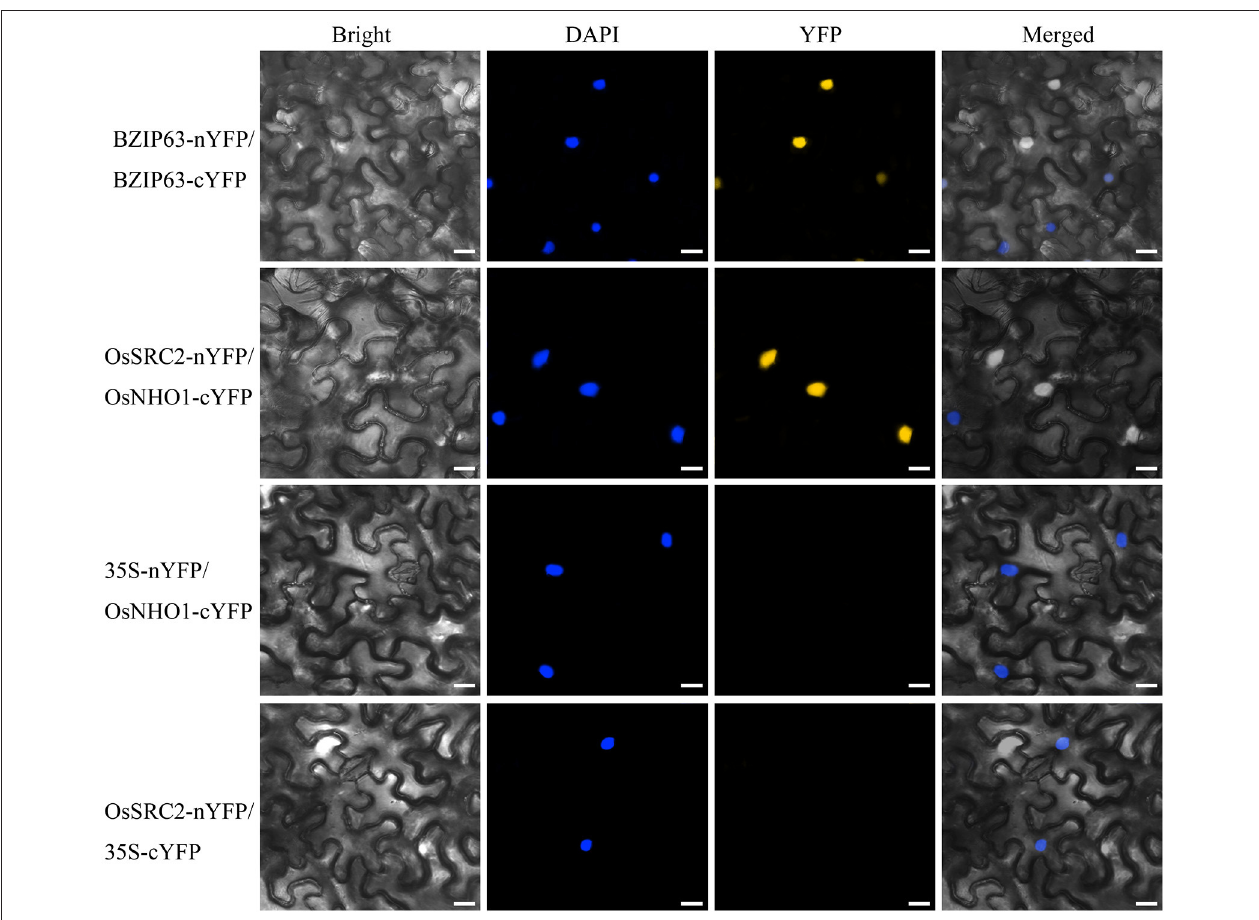
FIGURE 8 | In vivo interaction between OsNHO1 and OsSRC2 by BiFC analysis. N. benthamiana leaves were co-infiltrated with Agrobacterium carrying 35S::OsSRC2-nYFP and 35S::OsNHO1-cYFP. BZIP63 was used as a positive control. 35S-nYFP/OsNHO1-cYFP and OsSRC2-nYFP/35S-cYFP were used as negative controls. Fluorescence [yellow fluorescent protein (YFP)] and bright and merged field confocal images were acquired at 72h. DAPI was used for nuclear staining. Scale bars = 20 µ